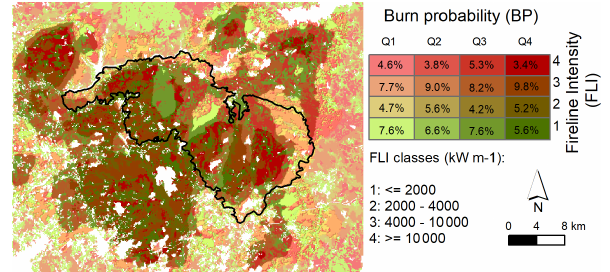
Figure 5. Spatial combination of the simulated BP and FLI using burn probability quartiles and FLI classes defined according to fire suppression difficulty as a proxy for wildfire hazard. In the map lighter colors have lower BP, while reddish colors are assigned to higher estimates of FLI.